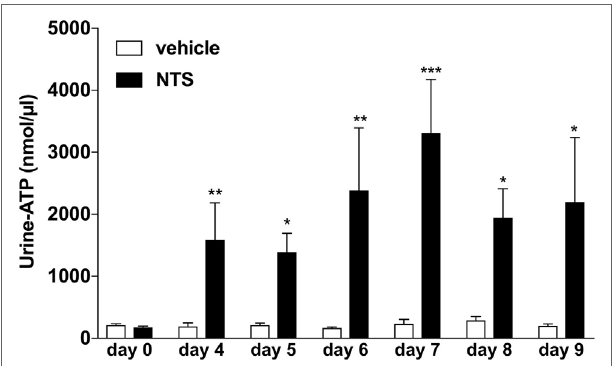
FigUre 1 | Functional analysis of urine-adenosine-5’-triphosphate (ATP) concentrations following nephrotoxic serum (NTS)-driven glomerulonephritis (GN). C57BL/6 mice received either vehicle (PBS) or (NTS solved in PBS) intravenously on days 1, 2, and 3 to induce GN. Urine of the animals was collected daily and analyzed for its ATP content. Data are shown as mean ± SEM, n = 5–8 mice in each group. Data from one representative experiment out of three are